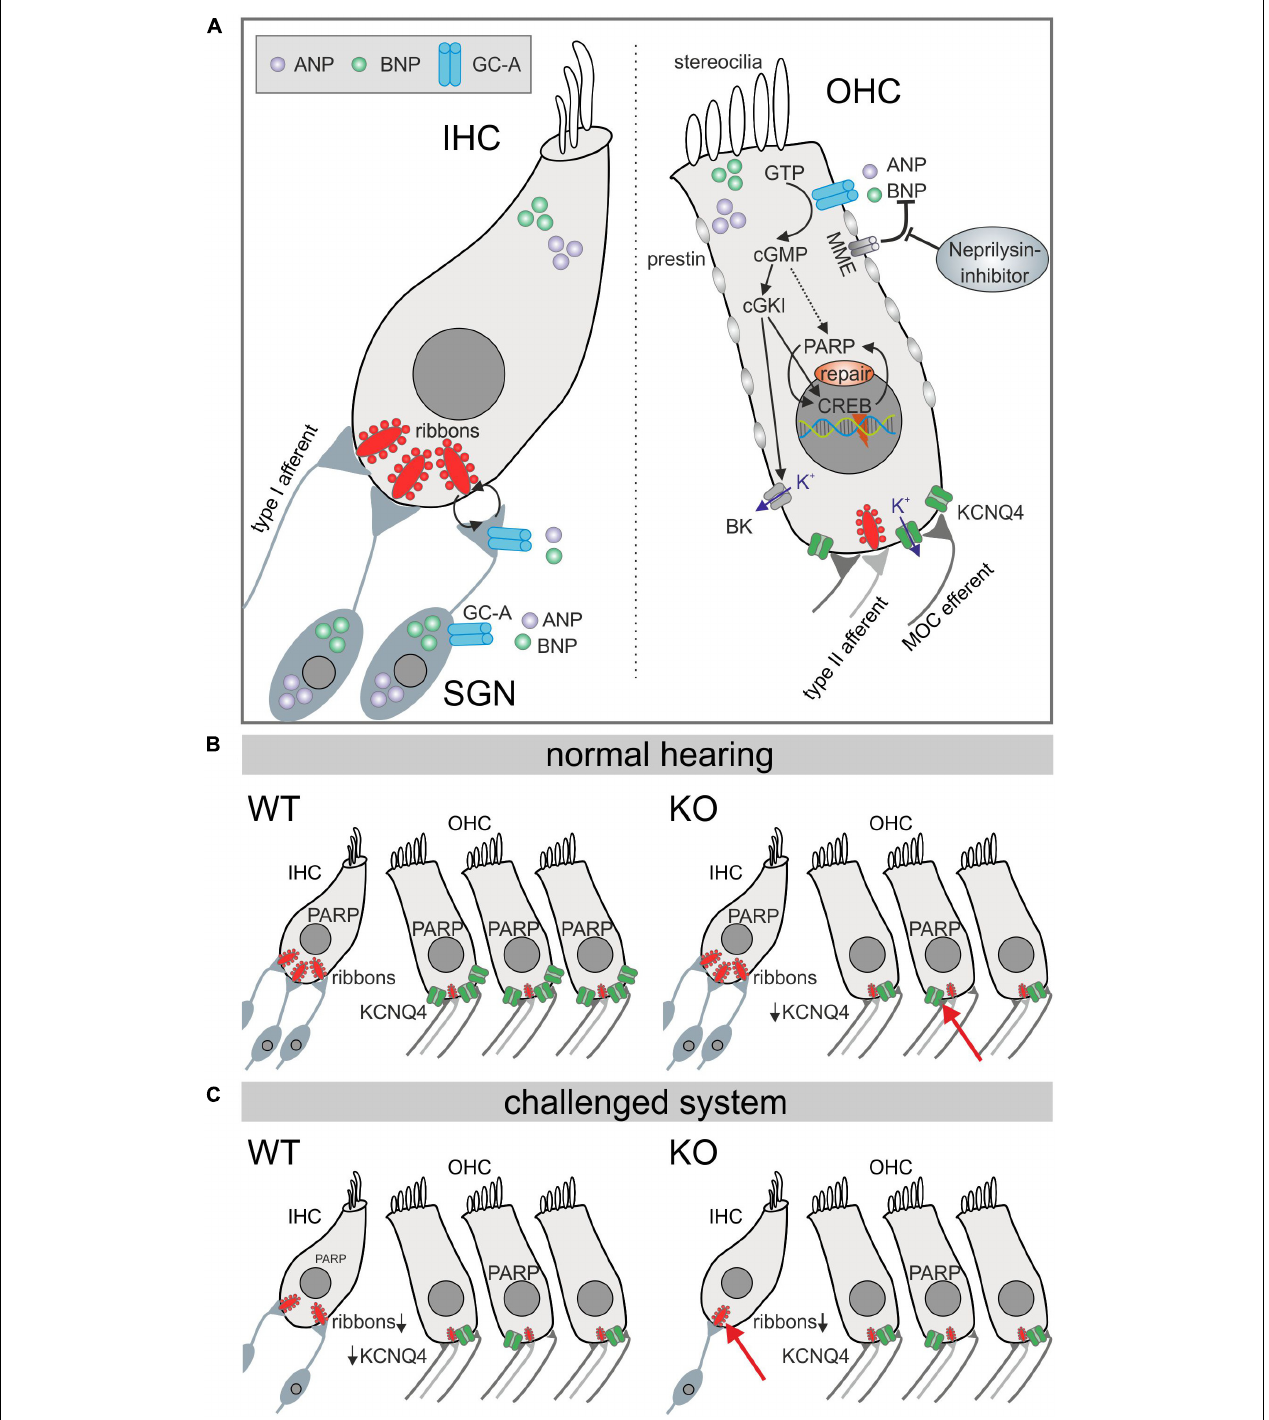
FIGURE 9 | Diagram illustrating GC-A/cGMP signaling mechanisms in auditory hair cells. (A) Summery of GC-A dependent intercellular signaling in IHC, OHC, and SGNs. The natriuretic peptides ANP (violet) and BNP (bright green) both bind to the membrane bound GC-A (blue) in OHCs or the SGN and activate a cGMP dependent cascade that ends in PARP increase. The effects in IHCs are due to pre- and postsynaptic integrity. (B) In the basic hearing situation, the number of IHC ribbons is not reduced in GC-A KOs, but in OHCs, KCNQ4 is impaired which leads to a functional phenotype measureable in DPOAE growth functions. (C) However, in the challenged system after acoustic overexposure or in aged animals, the number of IHC ribbons is more reduced in GC-A KO mice compared with WT which is correlated with a decreased ABR wave I amplitude, while OHCs are unaffected.